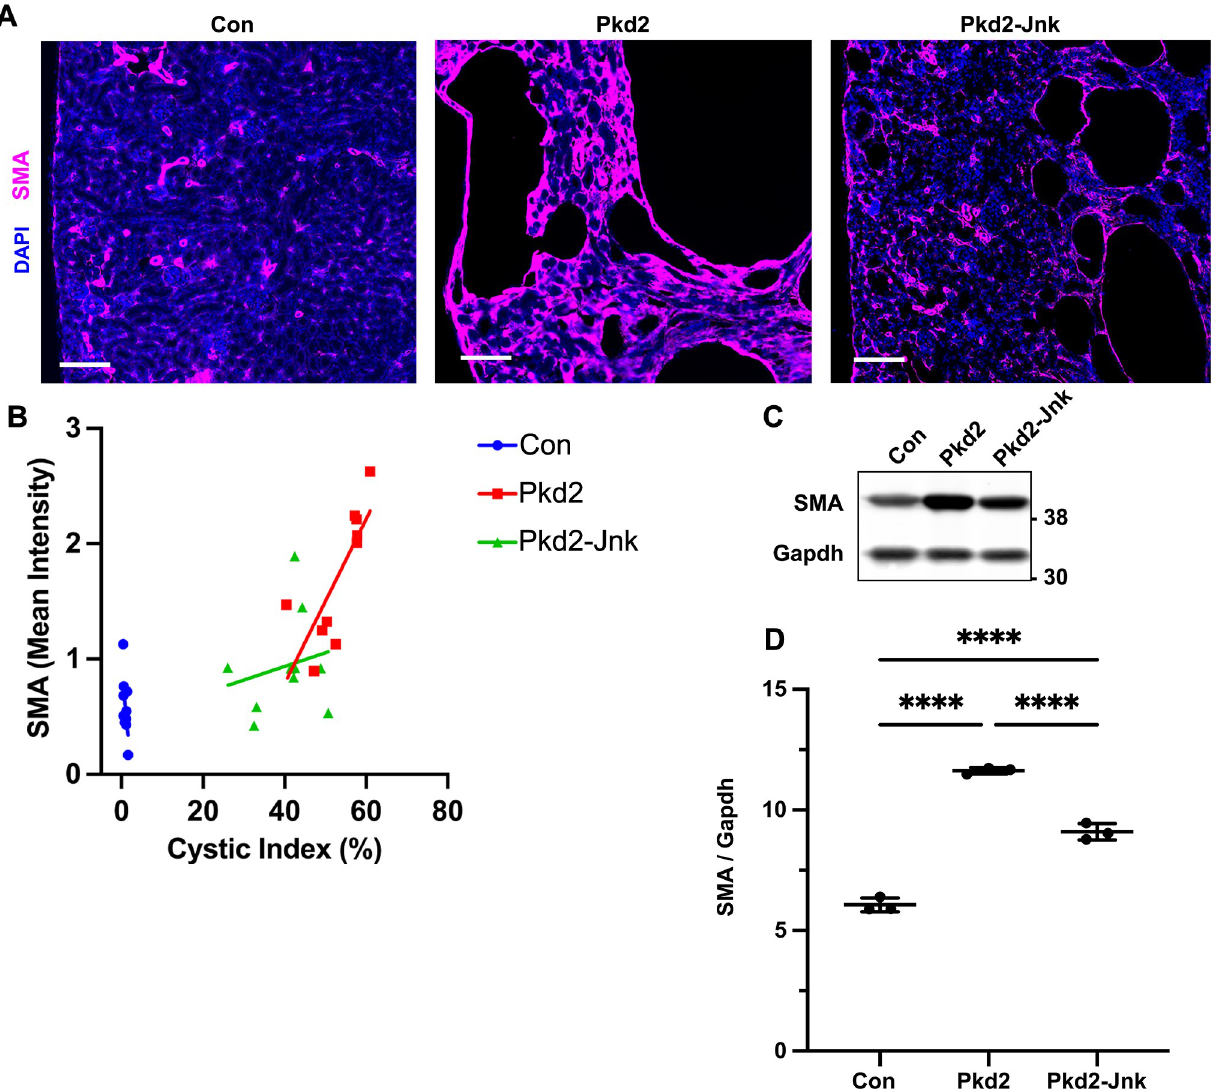
Fig 5. JNK inhibition reduces fibrosis in juvenile Pkd2 mutant mice. Mice with the following genotypes were treated with tamoxifen by maternal transfer at P2-4 and collected at P21: Con (Rosa26-CreERT2; Pkd2fl/+), Pkd2 (Rosa26-CreERT2; Pkd2fl/fl; Jnk1+/+, fl/+; Jnk2+/+, +/-), and Pkd2-Jnk (Rosa26-CreERT2; Pkd2fl/fl; Jnk1fl/fl; Jnk2null/null). (A) Kidney sections from P21 mice were probed for SMA, a marker of active fibroblasts. Nuclei were stained with DAPI. Images were obtained on Zeiss Axio Scan.Z1 with 20X objective. Scale bar is 100 microns. (B) SMA intensity was compared to cystic index for 10 animals per group. SMA mean intensity was measured using ImageJ software and divided by non-cystic area (mean intensity / non- cystic area x 100,000). Cystic index (cystic area / total area x 100%) was determined for DAPI staining using Image J software. Linear regression analysis shows that the difference between slopes for Pkd2 (y = 0.07x-2) and Pkd2-Jnk (y = 0.01x+0.5) approaches but does not reach significance (P = 0.055). (C) Whole kidney protein samples from P21 mice were immunoblotted for SMA and loading control Gapdh. (D) Quantification of immunoblots described in (C). N is 3 animals per groups. ���� , P < 0.0001 by one-way ANOVA followed by Tukey multiple comparison test with multiplicity-adjusted p-values. Error bars indicate